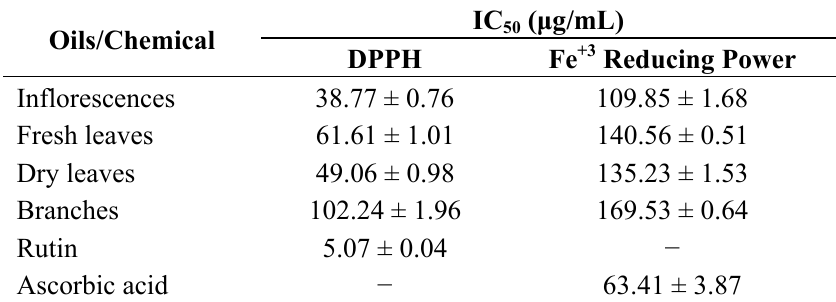
Table 4. Antioxidant activity of the essential oils of E. erythropappus